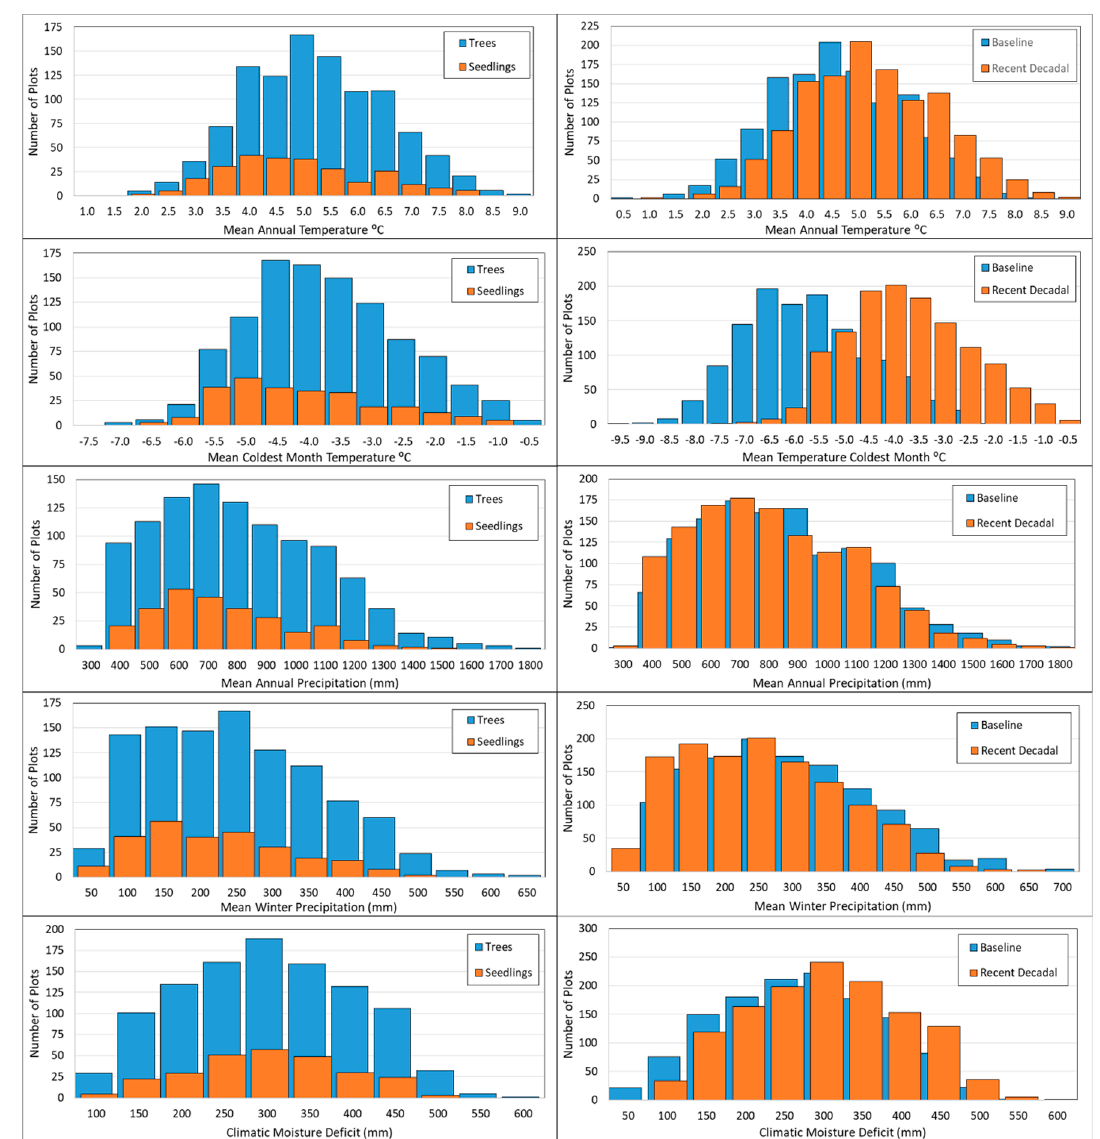
Figure 6. Histograms displaying the distribution of plots occupied by seedlings and mature trees relative to selected climatic variables (left column) and the distribution of data values from both baseline (1961–1990) and recent decadal (2001–2010) time periods (right column) relative to selected climatic variables.